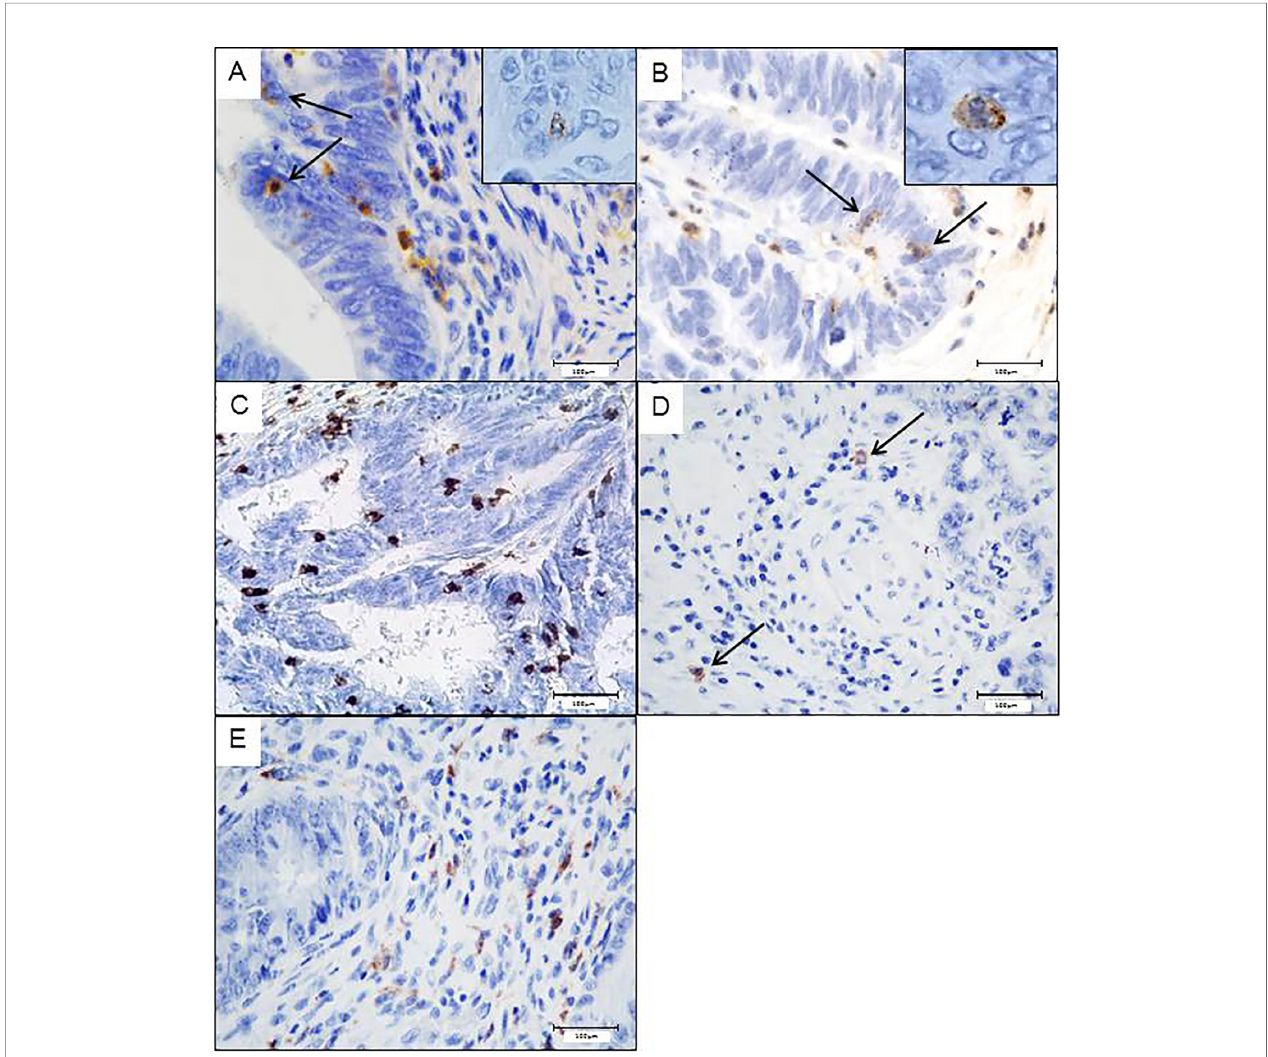
FIGURE 2 | Potential intraepithelial ADCC effector immune cells in colorectal tumors assess by immunohistochemistry. Intraepithelial Fc g RIIIA + (CD16) lymphocytes (A) or neutrophils (B) . CD8 + lymphocytes in close contact with tumor cells (C) . Scarce Nkp46 + Nk cells, only observed in the stroma (D) . CD163 + macrophages only found in the stroma (E)